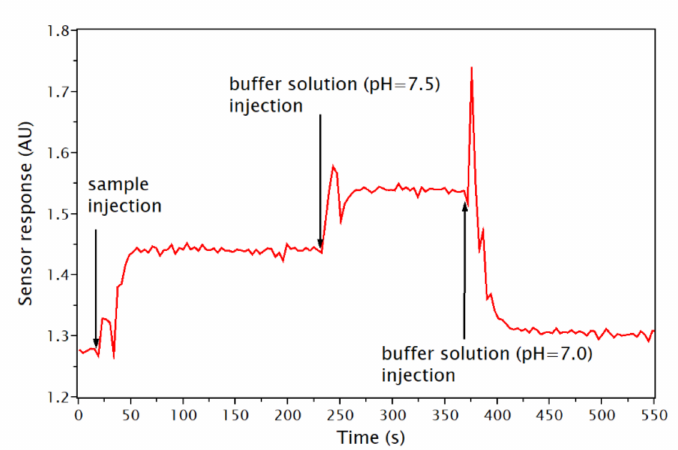
Figure 7. Sensor response in time during a measurement of a